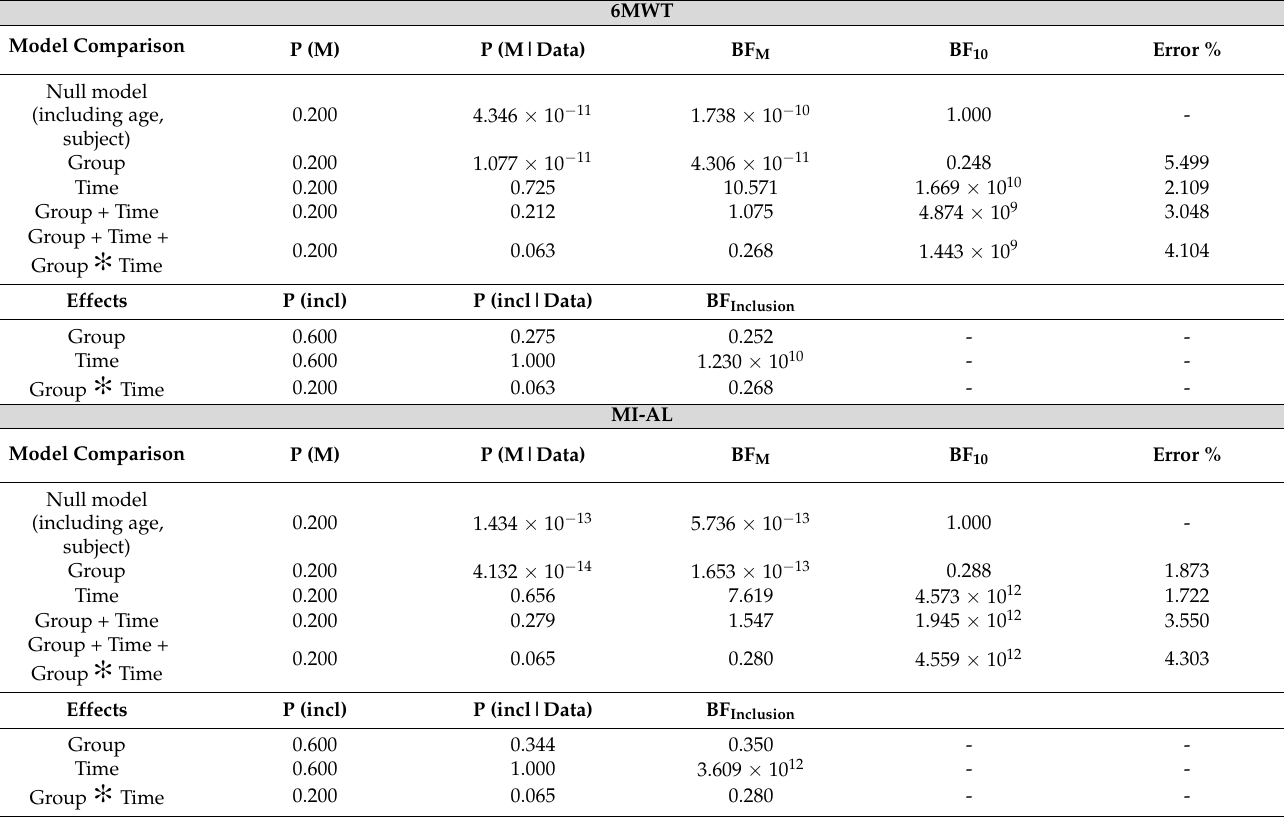
Table 3. Results of the chi-squared test between the Modified Ashworth Scale of the Affected lower Limb (MAS-AL), Functional Ambulation Classification (FAC), and Walking Handicap Scale (WHS) classes and the Experimental Group (EG) and Control Group (CG)